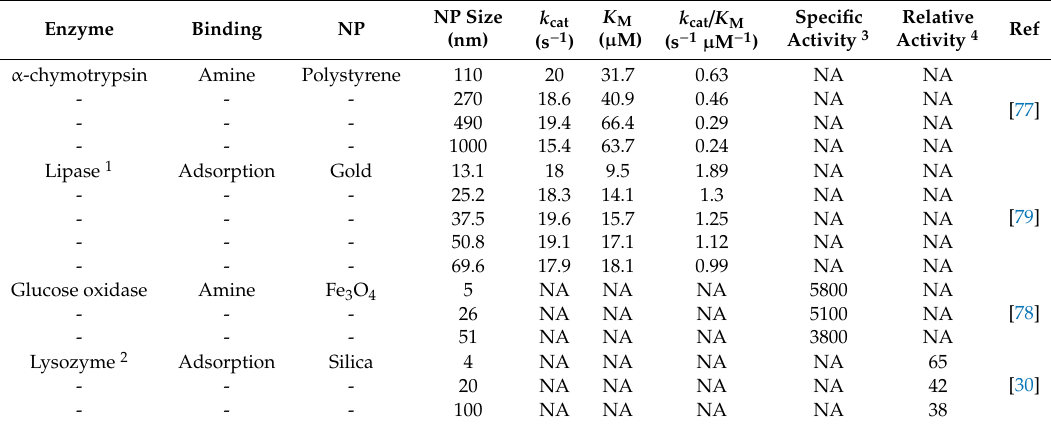
Table 2. Prior studies involving e ff ects of NP size on bound enzyme